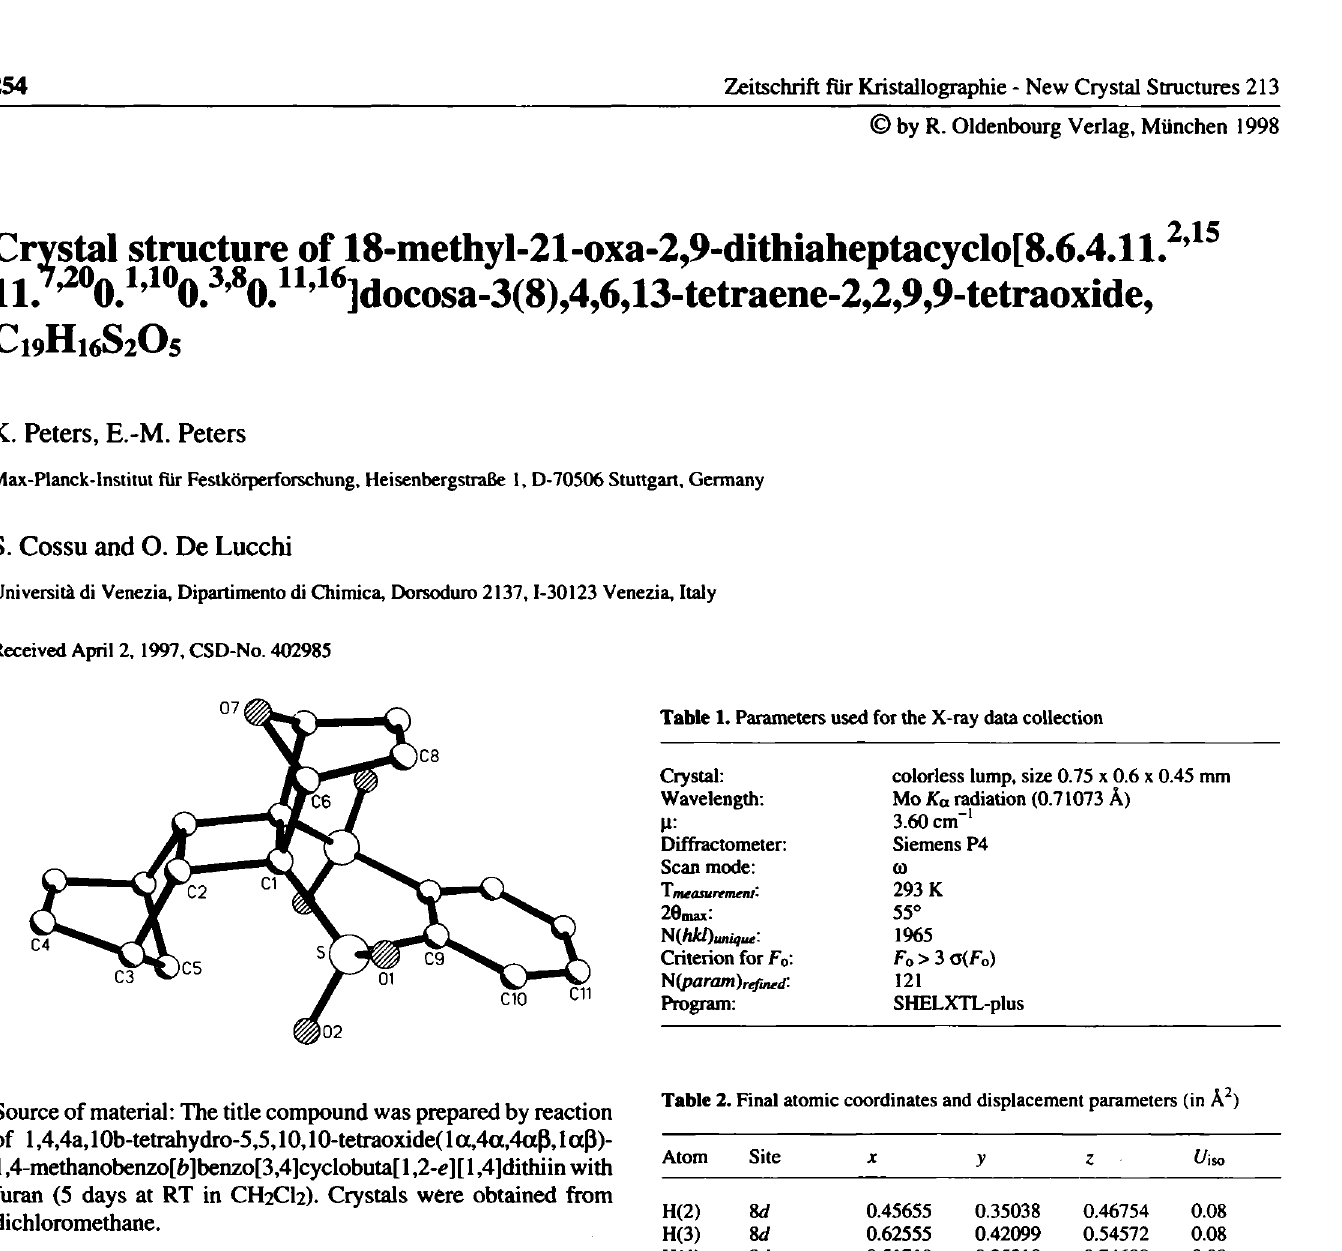
Table 2. Final atomic coordinates and displacement parameters (in